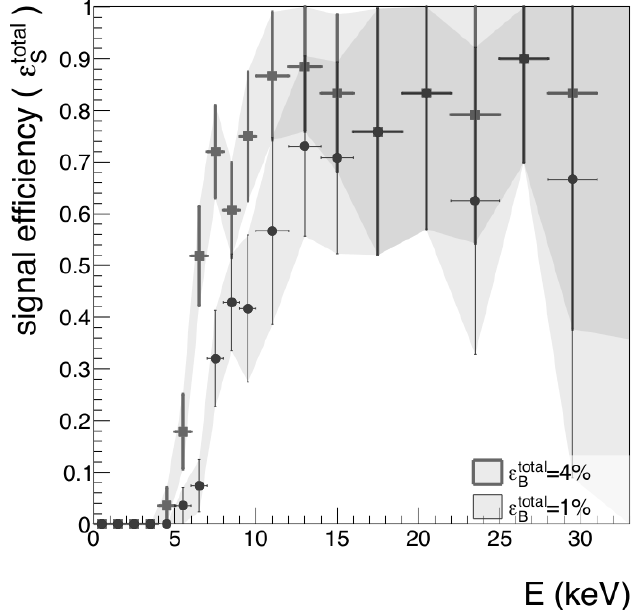
Figure 8. Detection efficiency for nuclear recoils ( (cid:101) total s ) as a function of their detected energy for electron recoils efficiency of 4% (squares) and 1%